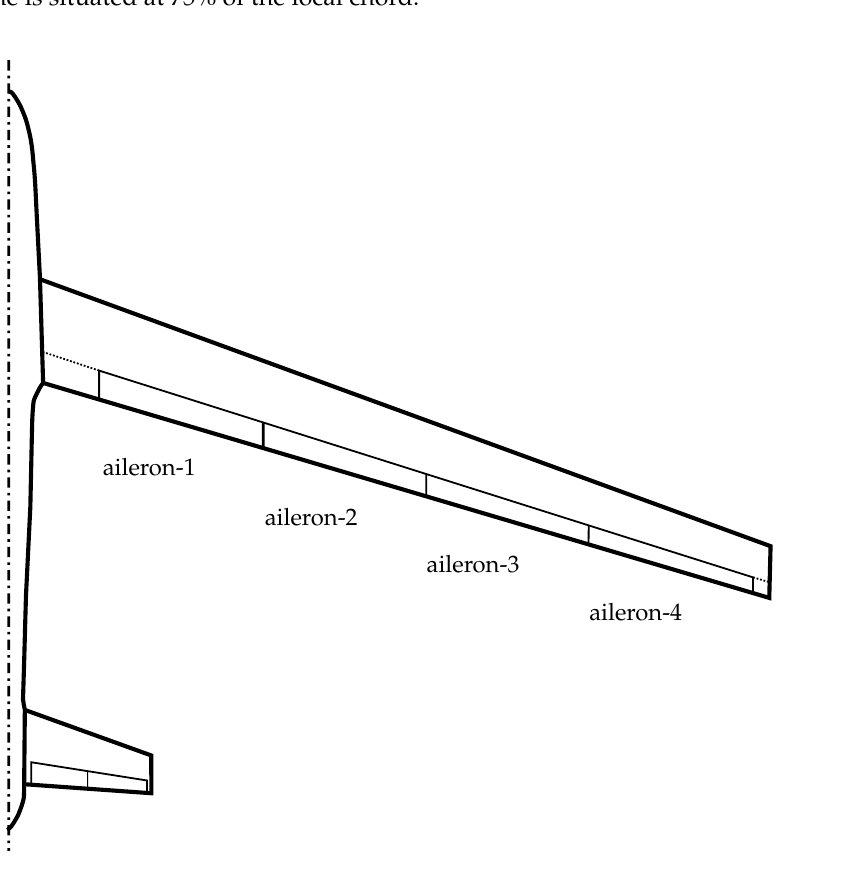
Figure 2. Aileron layout of the FLEXOP configuration.